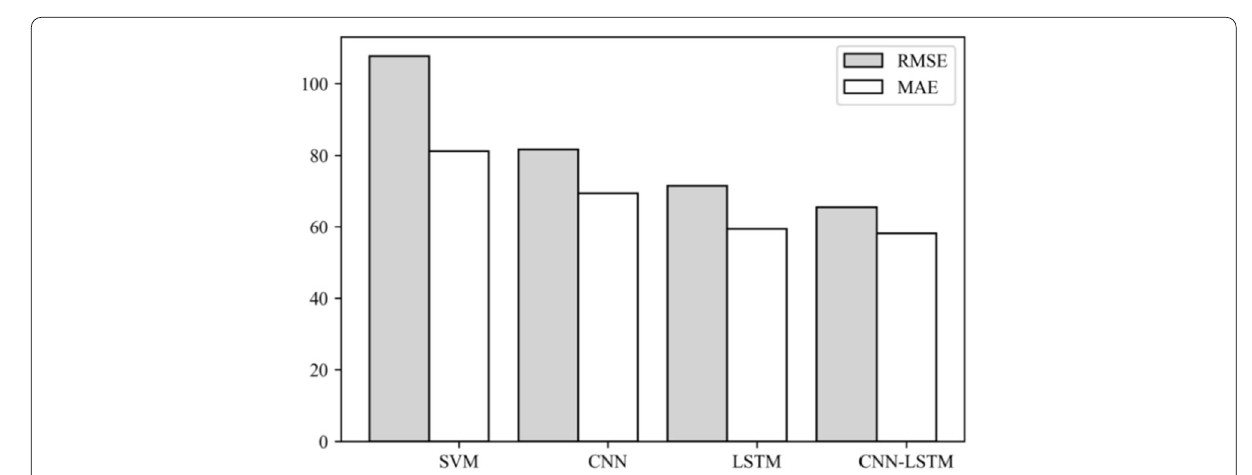
Figure 7 The modelling results of different feature extraction